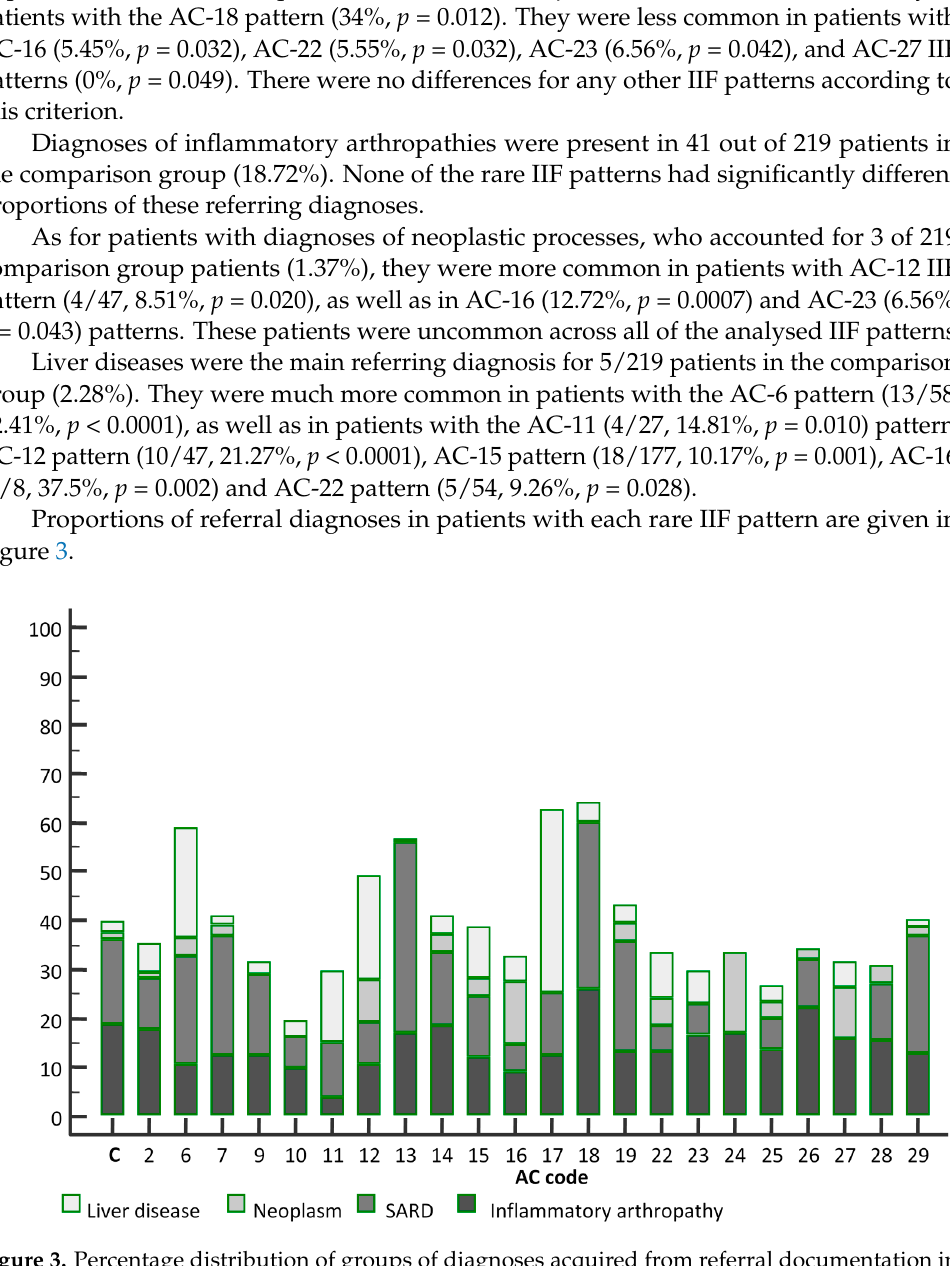
Figure 3. Percentage distribution of groups of diagnoses acquired from referral documentation in patients with particular rare IIF patterns determined using indirect immunofluorescence assay on HEp-2 cells in 1:100 dilution; C = comparison group.